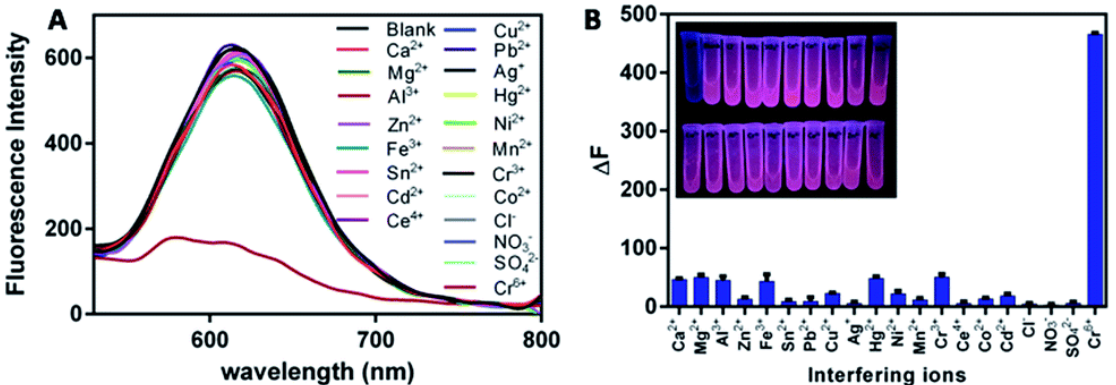
Figure 13. Specific determination of Cr(VI)-etched BSA-Au NCs. ( A ) Luminescence emission spectra of BSA-Au NCs after adding different ions. ( B ) The degree of luminescence change of BSA-Au NCs after adding different ions (the inset is the imaging under UV light). Reprinted with permission from Ref. [32]. Copyright © 2016 The Royal Society of Chemistry.